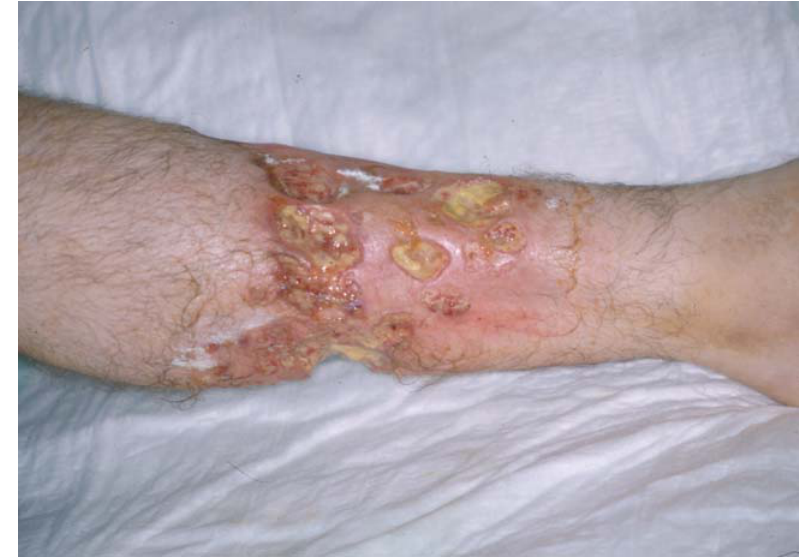
Fig. 1 Ulcerations due to pyoderma gangrenosum of our patient lower left leg (picture performed in April